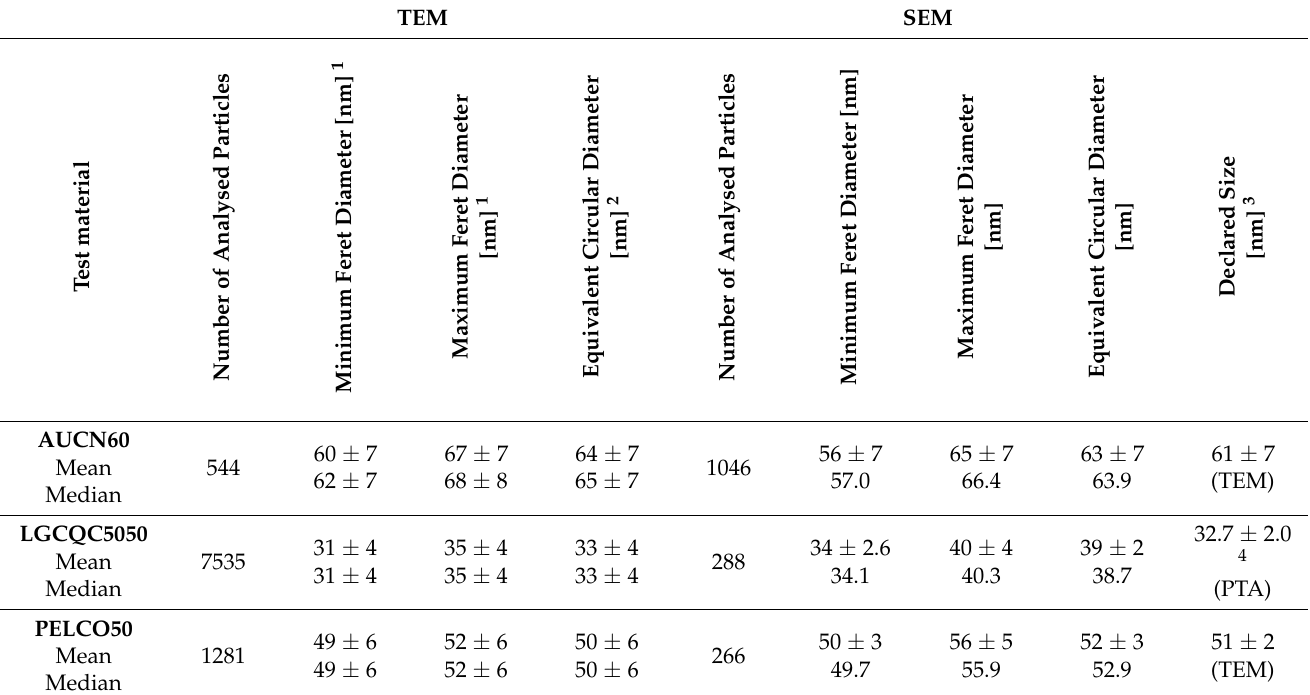
Table 5. Summary of the mean and median values of the minimum Feret diameter, the Feret diameter and the equivalent circular diameter obtained from the quantitative TEM and SEM analysis of the constituent gold particles of the tested materials.